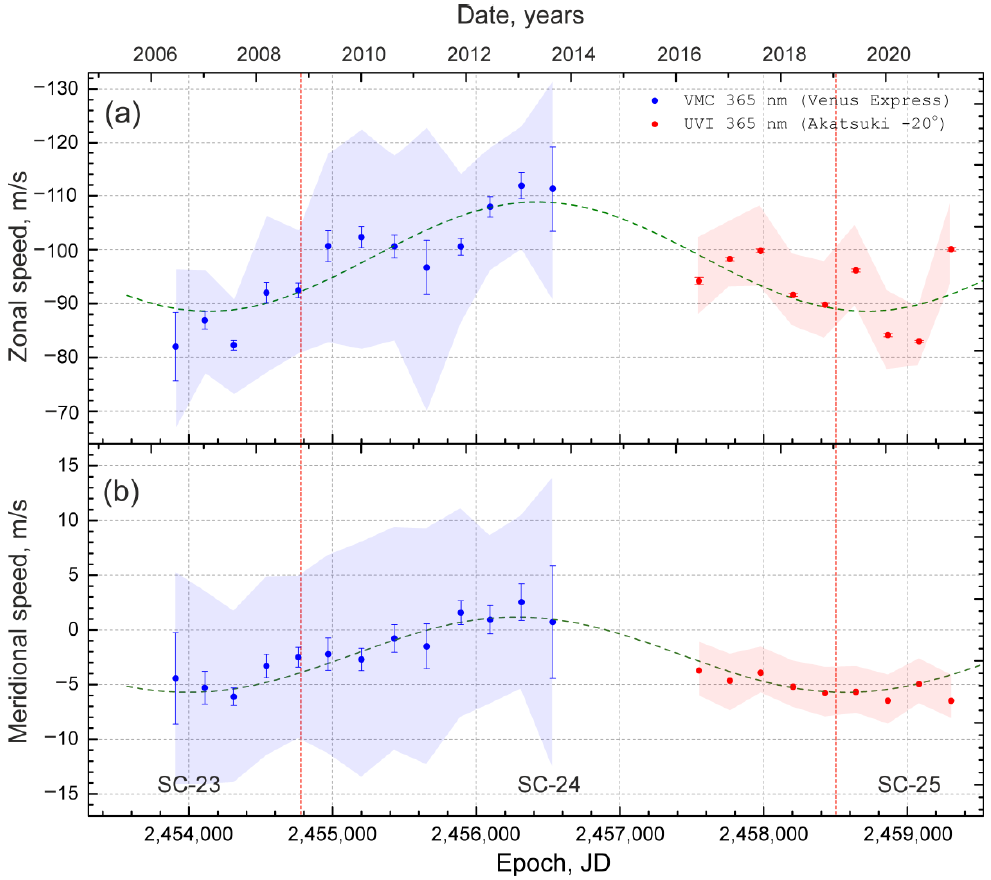
Figure 1. Long-term variations of the mean zonal ( a ) and meridional ( b ) wind speed at 20 ± 2.5 °S at around noon (12 ± 1 h LT) derived from VMC/ Venus Express (blue) and UVI/ Akatsuki (red) images. Each point is the result of averaging over one Venusian year (224.7 days). Vertical red dotted lines mark sequential minima of the solar cycle #24 (Figure S1). Olive dashed lines denote sine functions approximating the measurements. Error bars correspond to 99.6% confidence interval (3· σ x ). Colored shaded areas correspond to the standard deviations σ . The zonal wind component is negative, indicating east – west retrograde circulation. The negative sign of the meridional speed corresponds to north – south motions.